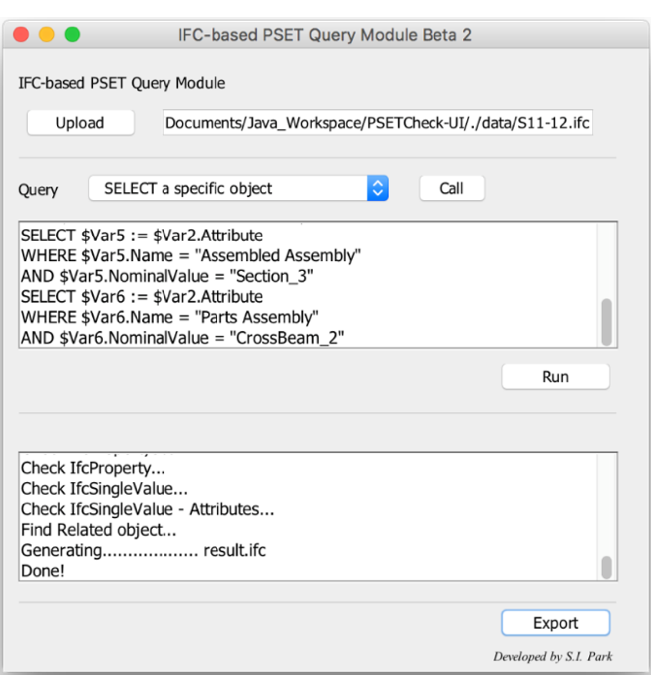
Figure 15. User-interface for semantic information management of bridge data model.